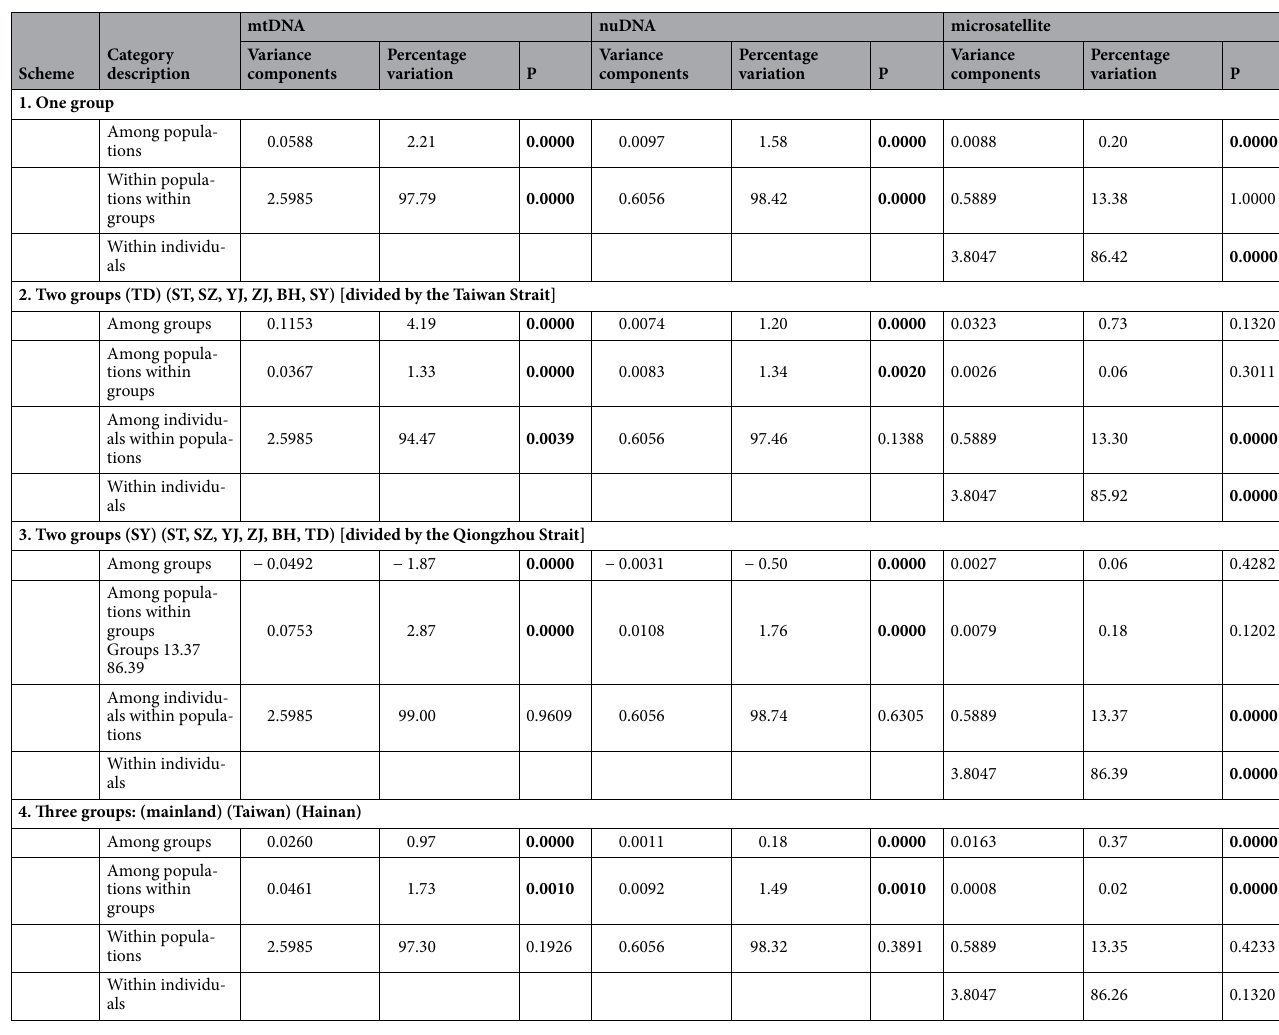
Table 2. Analysis of molecular variance (AMOVA) for Trichiurus nanhaiensis populations based on three molecular markers. Significant scores ( P < 0.05) are shown in bold